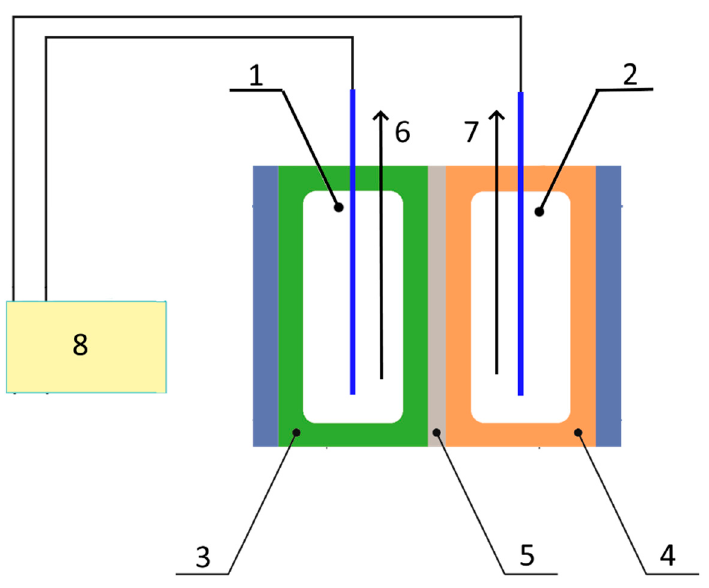
Figure 1. Experimental setup: (1) cathode (2) anode, (3) cathode chamber, (4) anode chamber, (5) Nafion membrane, (6,7) sampling syringes, (8) potentiostat connected to a computer. Hydrogen or oxygen bubbles were generated in the cathode and anode chambers, respectively. During sampling, syringe needles placed into both chambers were used. Needles were placed parallel to the electrodes, 1 cm to the side, the same distance to Nafion membrane as the electrodes. We started the DLS measurements within a minute of the sampling and did not shake the sampling vessel. Therefore we state that the density of size distribution did not change, and therefore the Sauter diameter stayed